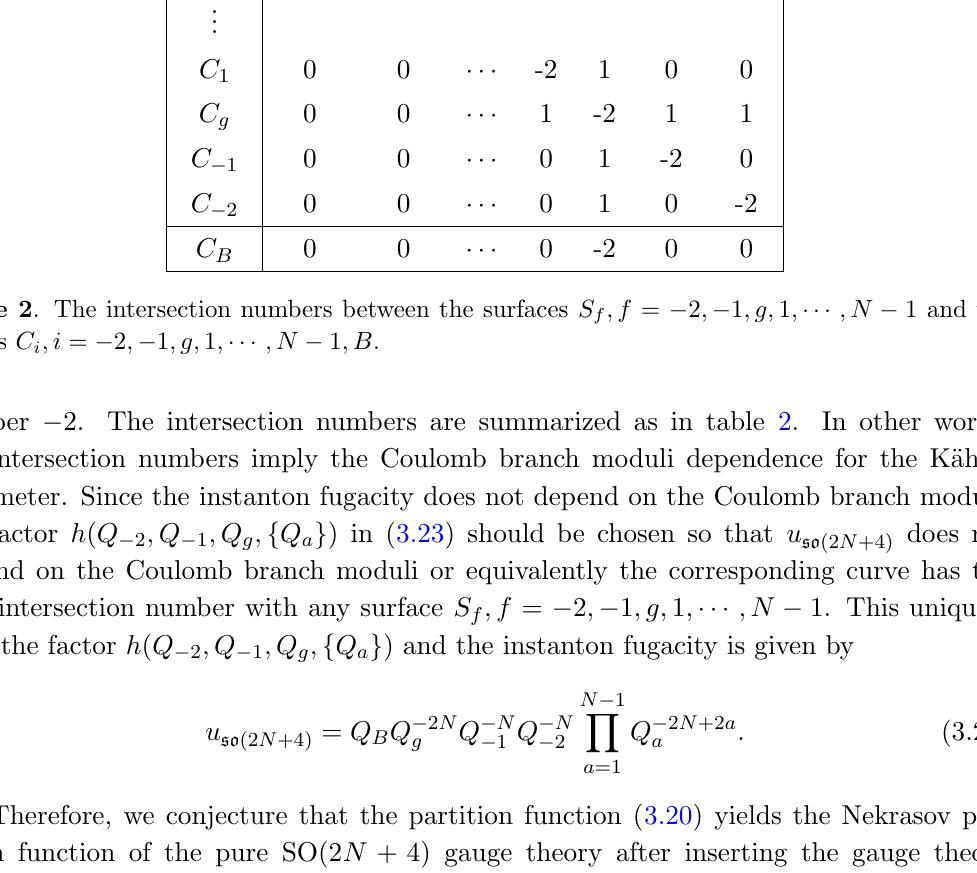
2 ; 1 ; g; 1 ; ; N 1 ; B (cid:0) (cid:0) (cid:1) (cid:1) (cid:1) (cid:0)